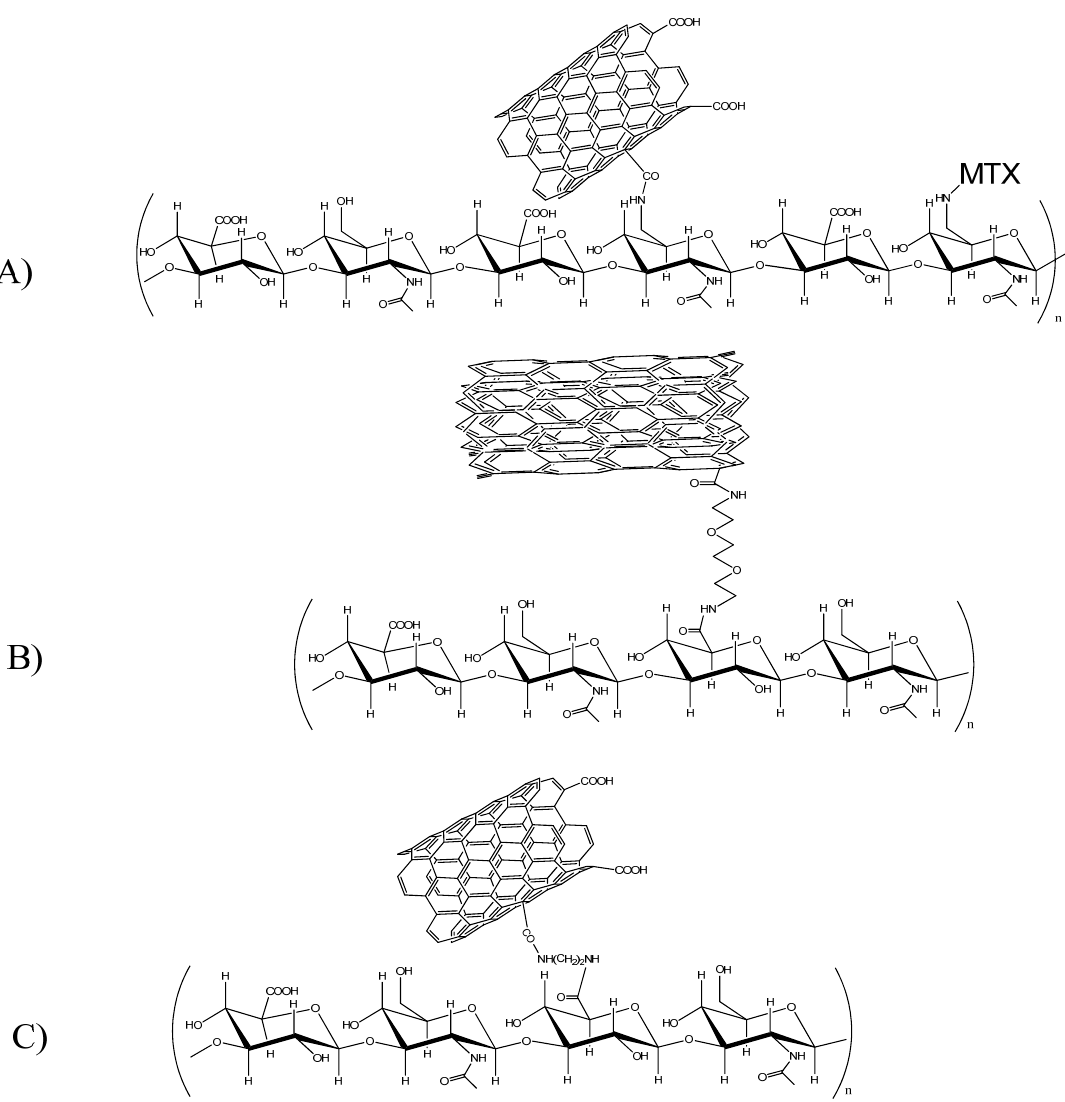
Figure 4. Different ways to conjugate carbon nanotubes to HA (MTX ‒